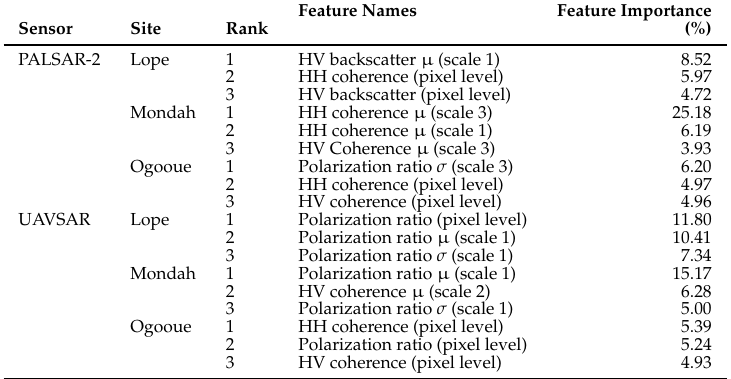
Table 6. Feature importances from the RF model as defined in [70] trained on areas with AGB above 100 Mg/ha using InSAR coherence and backscatter and all three superpixel-derived